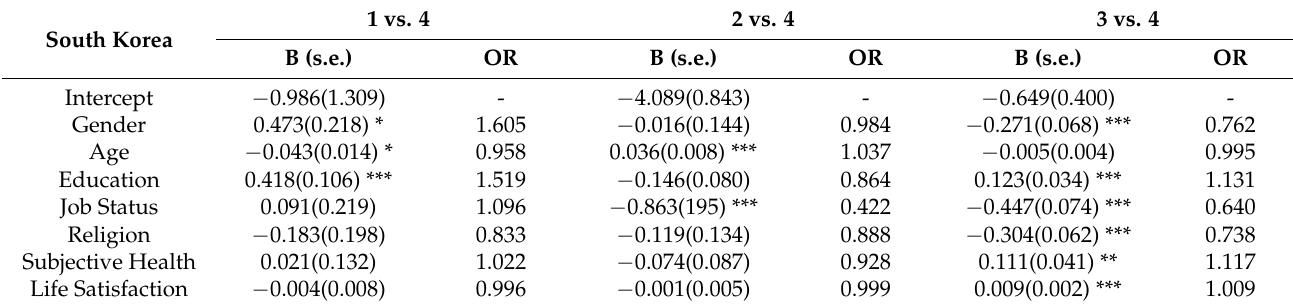
Table 4. Multinomial Logistic Regressions.